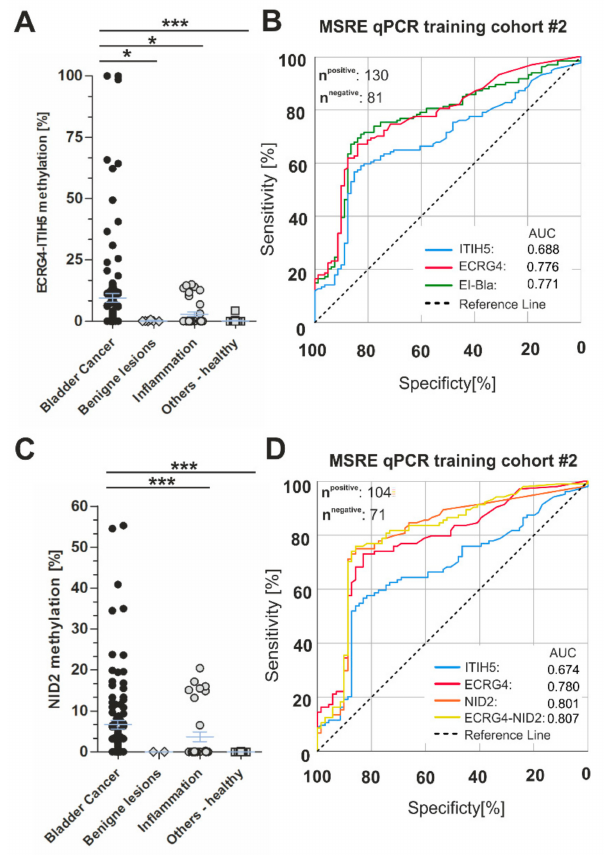
Figure 4. Biomarker performance of ECRG4 , ITIH5 , and the ECRG4 - ITIH5 panel assessed by an independent urine cohort (training cohort #2) and compared to NID2 using MSRE qPCR. ( A ) Scatter plot illustrates significant increased methylation levels for ECRG4 and ITIH5 in urine sediments of bladder cancer compared to benign lesions, inflammatory and healthy samples; *** p < 0.001, * p < 0.05. ( B ) ROC-curve analysis illustrating ECRG4 (red curve), ITIH5 (blue curve) and ECRG4 - ITIH5 (green curve) biomarker performance based on MSRE qPCR in cohort #2. ( C ) Scatter plot showed significant increased methylation values for NID2 in urine sediments of bladder cancer compared to benign lesions, inflammatory and healthy samples; *** p < 0.001. ( D ) ROC-curve analysis compares ECRG4 (red curve), ITIH5 (blue curve), and NID2 (orange curve) and combined ECRG4-NID2 biomarker performance based on MSRE qPCR in cohort #2. AUC : Area under the